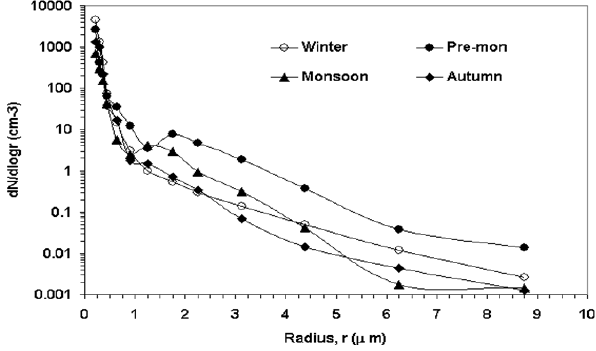
Fig. 2. Variation of monthly averages of observed AOD at 500nm (circle) over Delhi during Jan 06 – Jan 07, MODIS derived monthly average AOD at 550nm (square) and the Angstrom exponent α (triangle) calculated from observation.